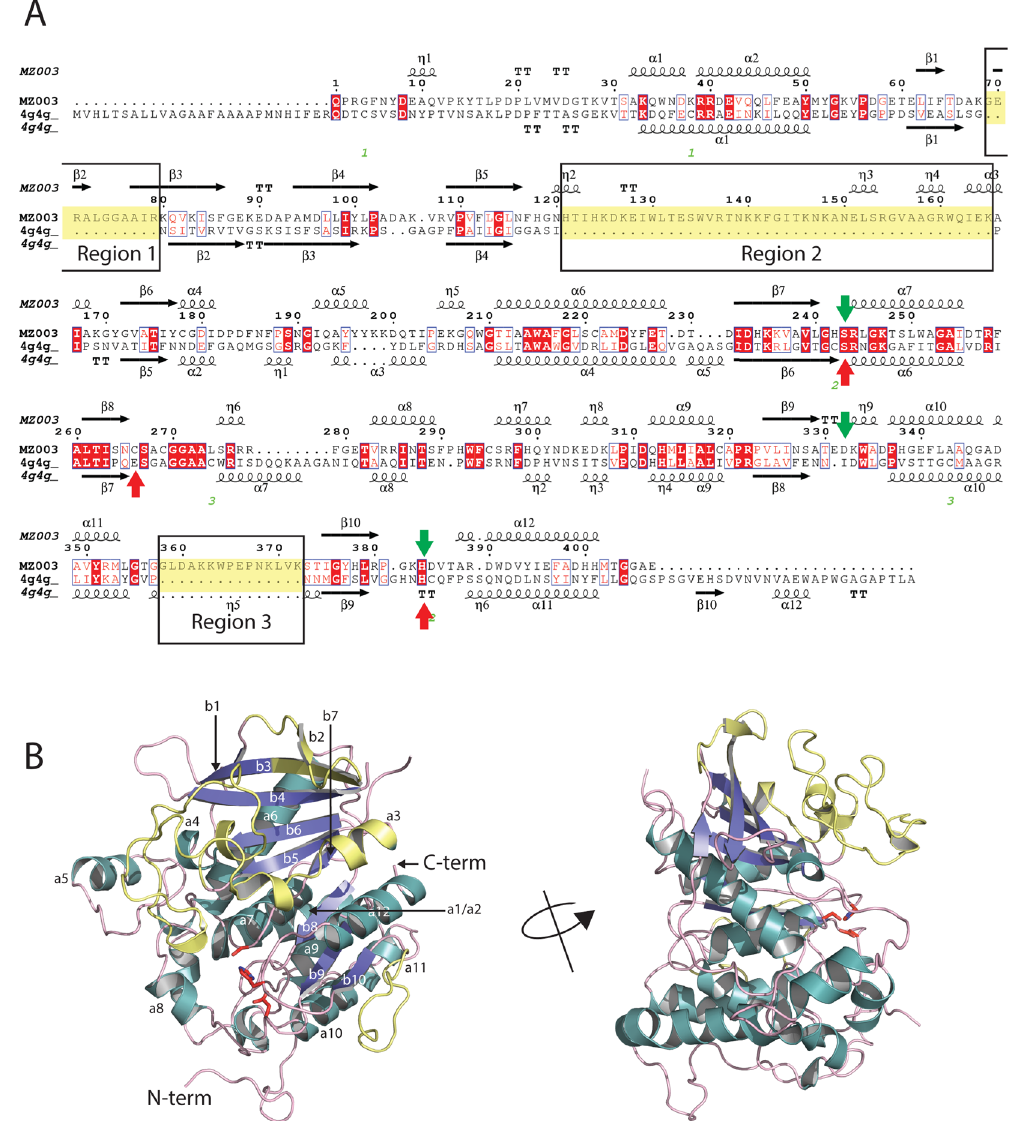
Figure 1. Structure-based sequence alignment ( A ) of MZ0003 with 4g4g, a CE15 from M . thermophilia . Fully conserved residues are highlighted in red; residues with conserved properties are indicated in red text. Residues of the catalytic triad are indicated with green and red arrows for MZ0003 and 4g4g respectively. Loop regions identified in MZ0003 which are not conserved in fungal CE15s are boxed and indicated in yellow. ( B ) Overall fold of the MZ0003 monomer. Novel loop regions are colored yellow, the side chains of the catalytic residues are shown in